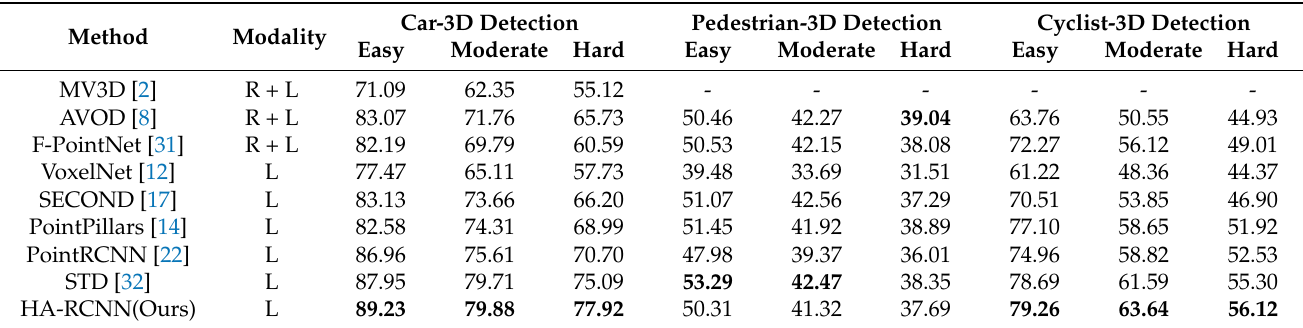
Table 2. Performance comparison with other 3D object detection algorithms (‘R’ denotes RGB image input and ‘L’ denotes Lidar point cloud input.)